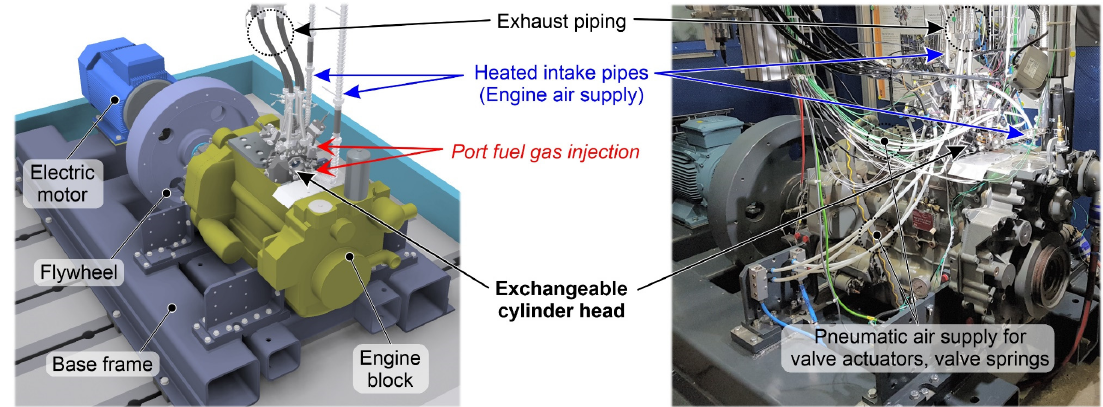
Figure 4. An overview of the new test rig: (left) the CAD design and (right) the real setup including all cables, pipes, pressurized air supply tubes, etc.